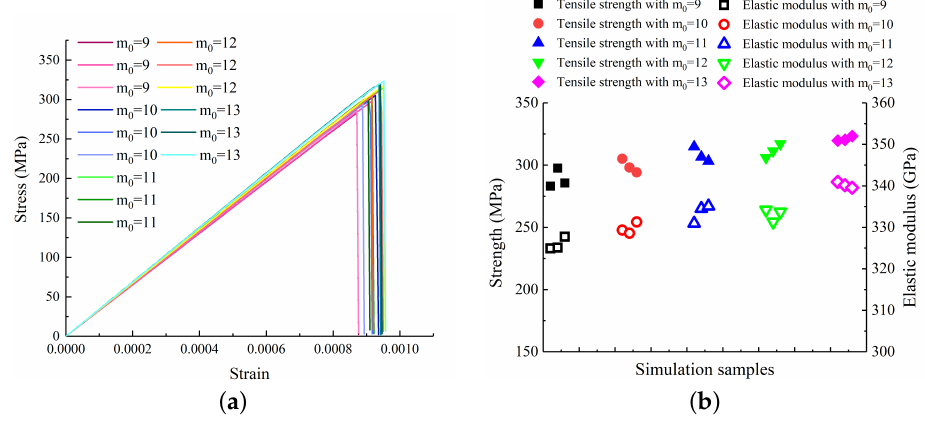
Figure 6. ( a ) The engineering stress-strain response of the CeramTec 98% alumina during the direct tension simulations with different Weibull modulus ( m 0 = 9, 10, 11, 12, and 13). ( b ) The full dots are the tensile strength and the hollow dots are the elastic modulus obtained by simulation with five different Weibull